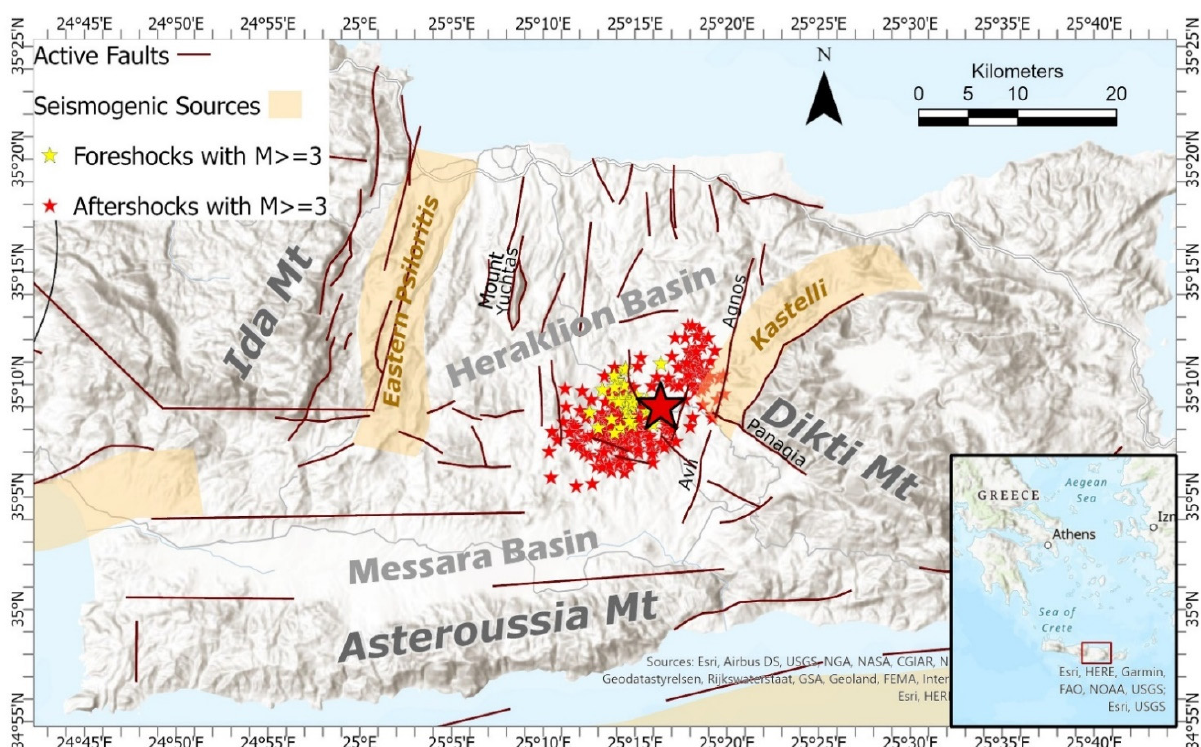
Figure 1. The map of Central Crete showing the epicenter of the main event and the foreshocks and aftershocks with magnitudes greater than or equal to M3.0 [26], the major active faults (adopted from [40]) and the seismogenic sources (adopted from [41]) located in the area. The Heraklion graben is bounded on the west by the Ida Mountains and on the east